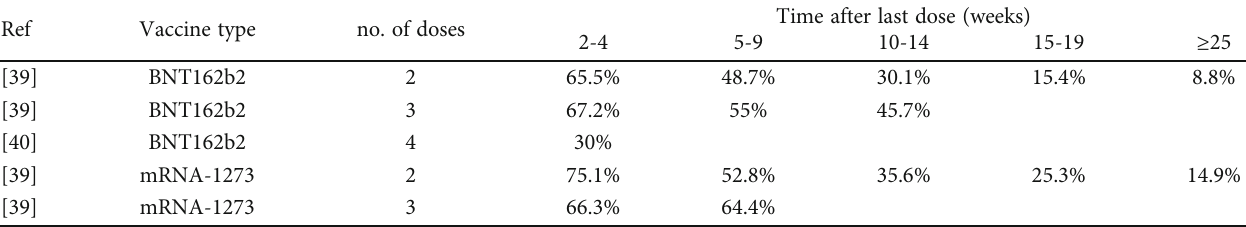
Table 1: E ff ectiveness against the SARS-CoV-2 Omicron (1.1.529) variant after 2 to 4 vaccine doses a . Ref Vaccine